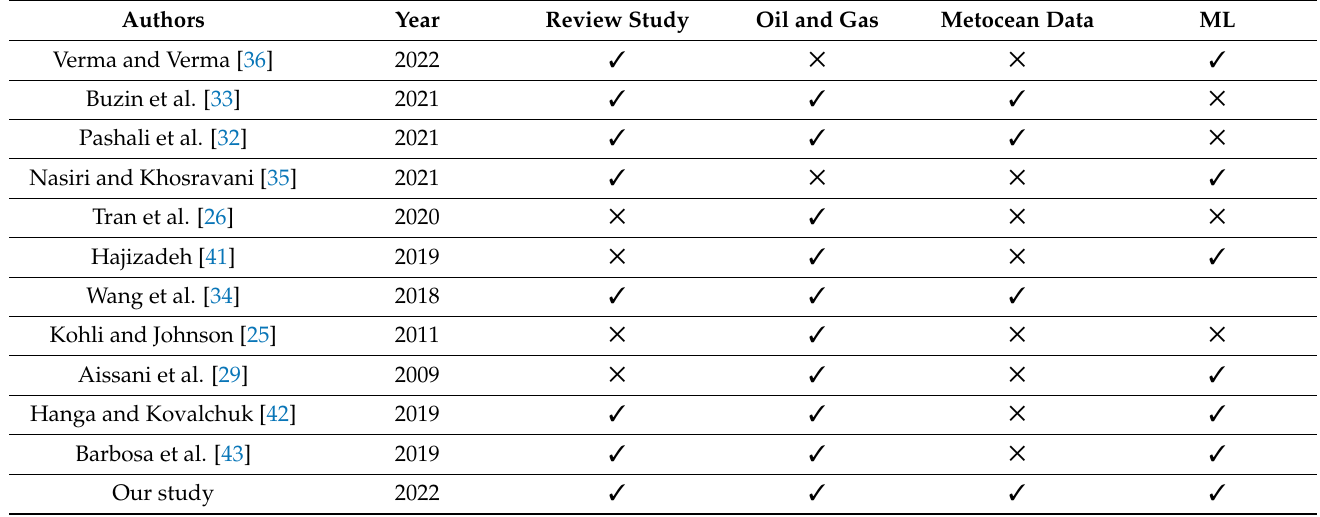
Table 1. Comparison of other related studies in the same domain: ( (cid:51) : Yes, (cid:53) :